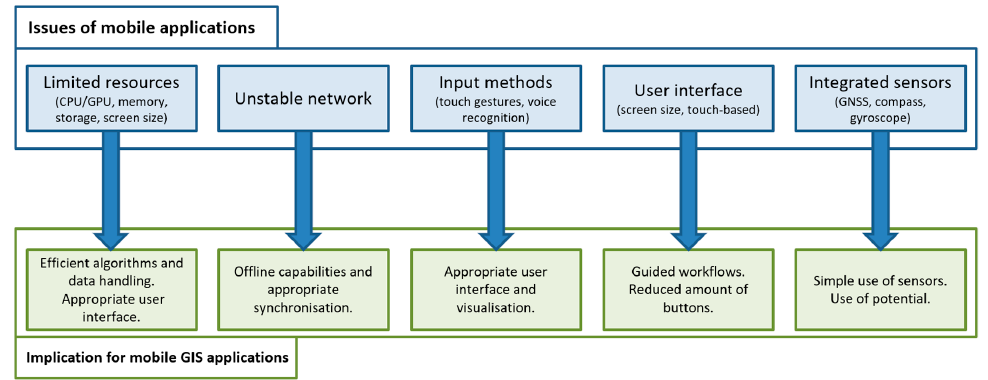
Figure 1. Issues of mobile applications and their implications for mobile GIS.